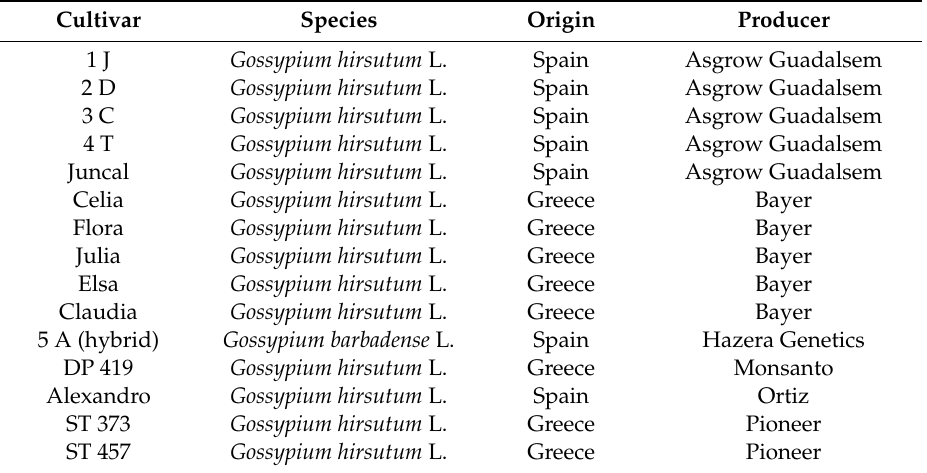
Table 1. List of cotton cultivars in the study in 2011.